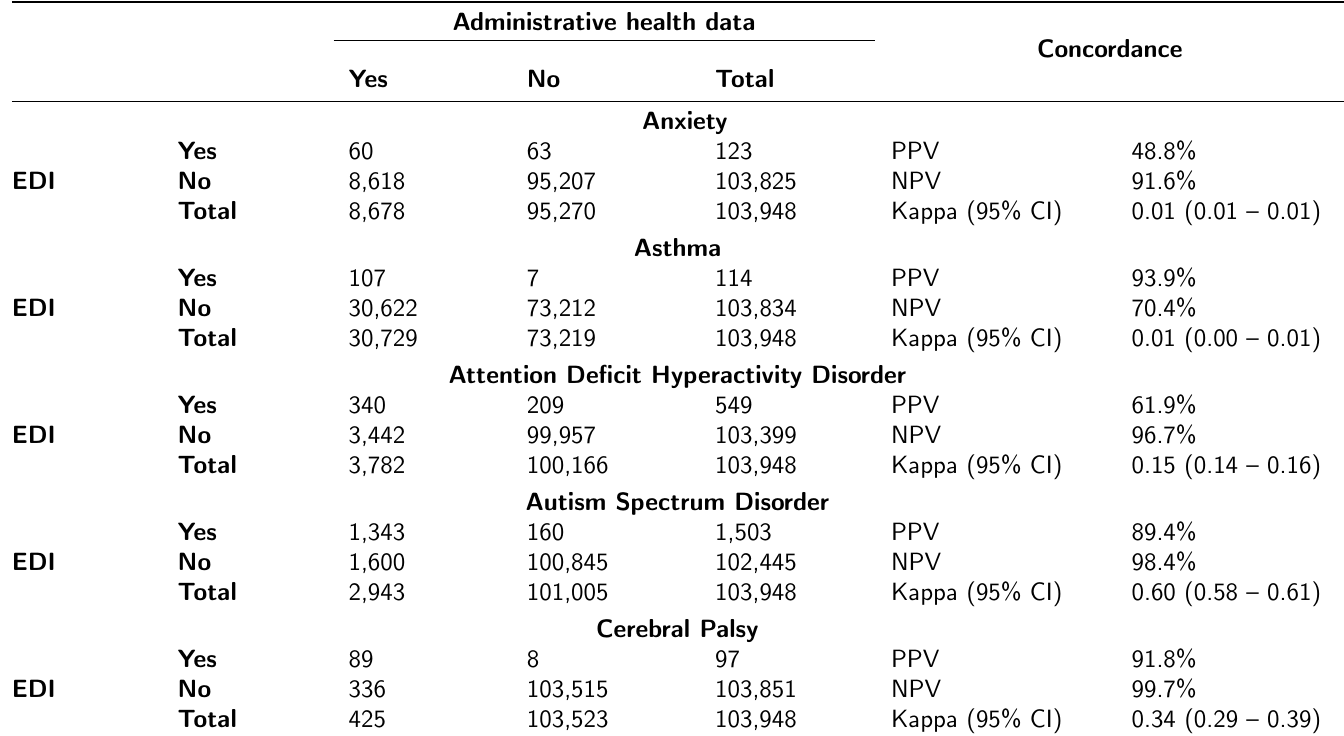
Table 3: Agreement of conditions commonly reported in the early development instrument with the condition’s identification in administrative